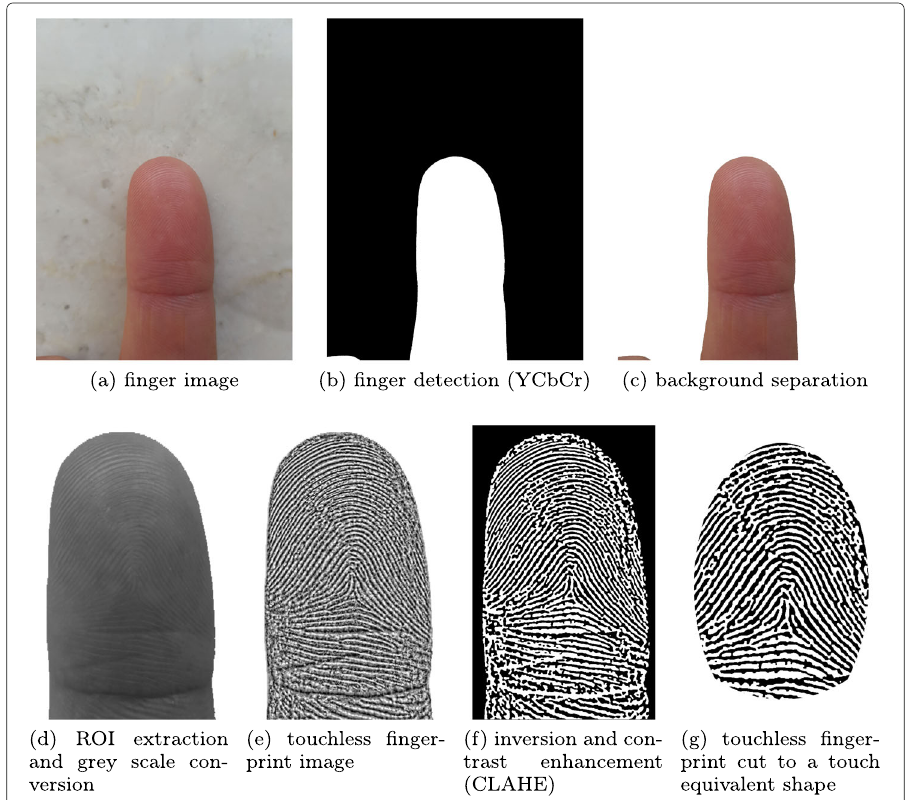
Fig. 4 Touchless preprocessing workflow. Example of a touchless preprocessing workflow based on a